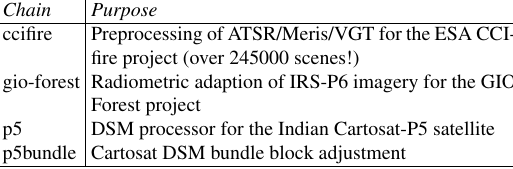
Table 3: Project specific processing chains in CATENA Chain